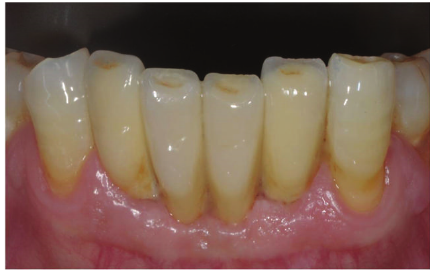
Figure 12: Clinical control 4 years after surgery.